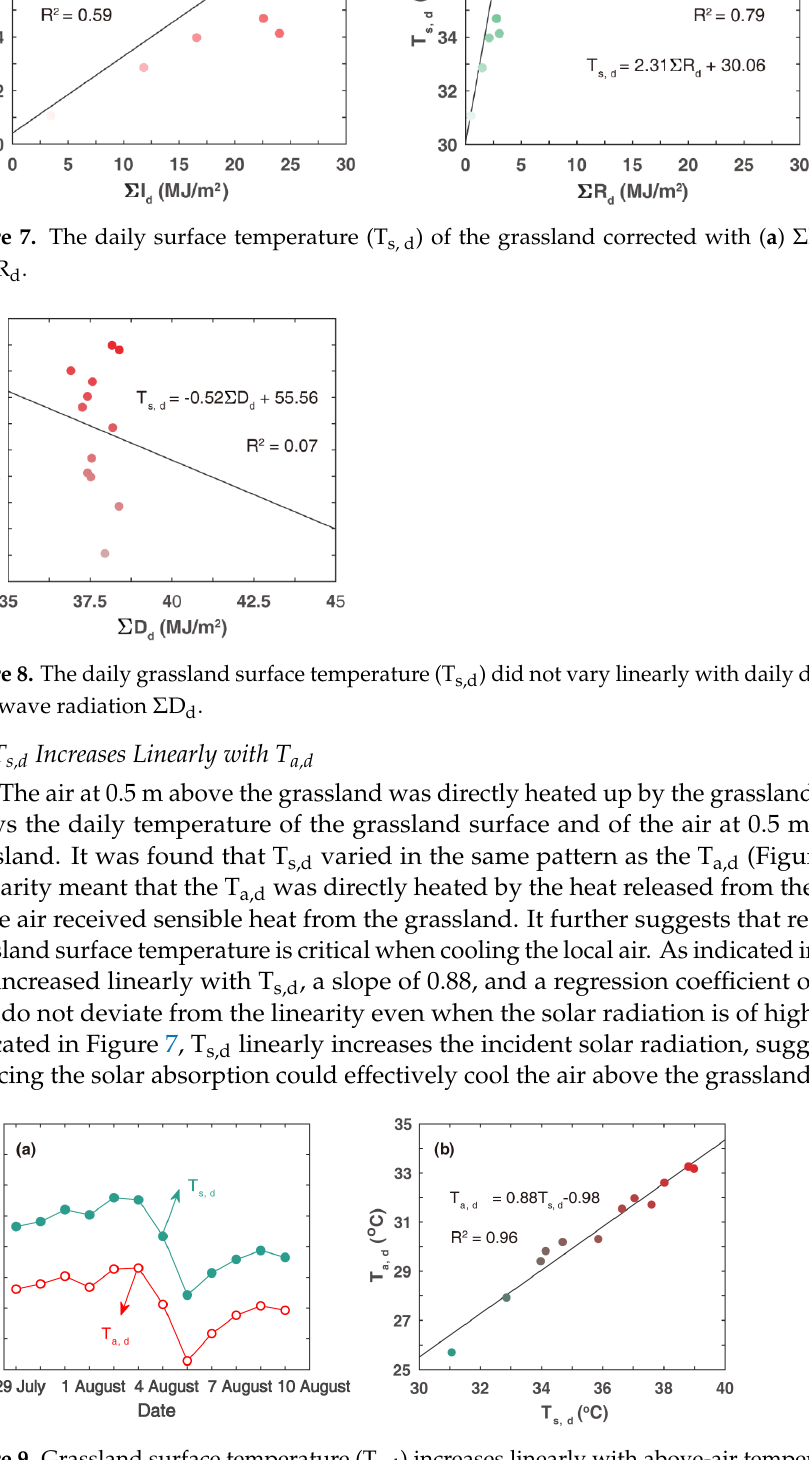
Figure 9. Grassland surface temperature (T s,d ) increases linearly with above-air temperature (T a,d ). ( a ) variation of daily average temperature, ( b ) relationship between T s,d and T a,d .